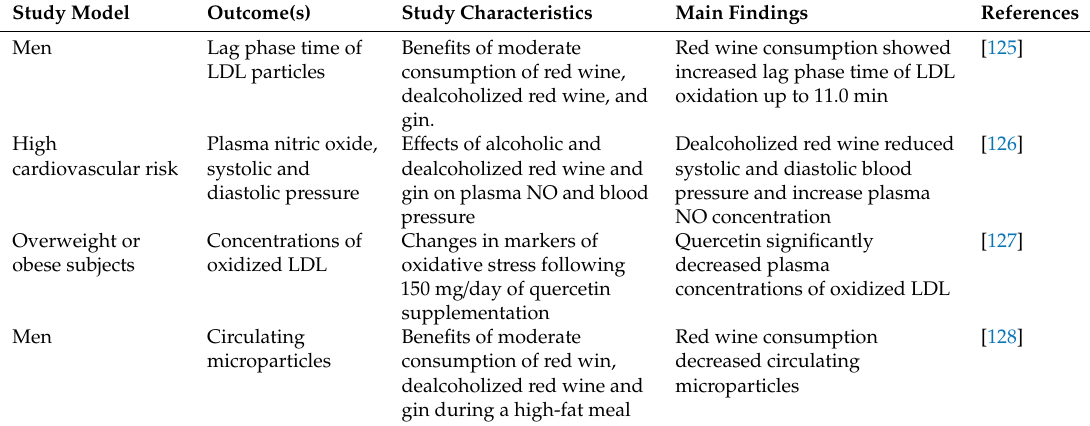
Table 4. Summary of studies assessing the impact of red wine consumption on oxidative stress. LDL: low-density